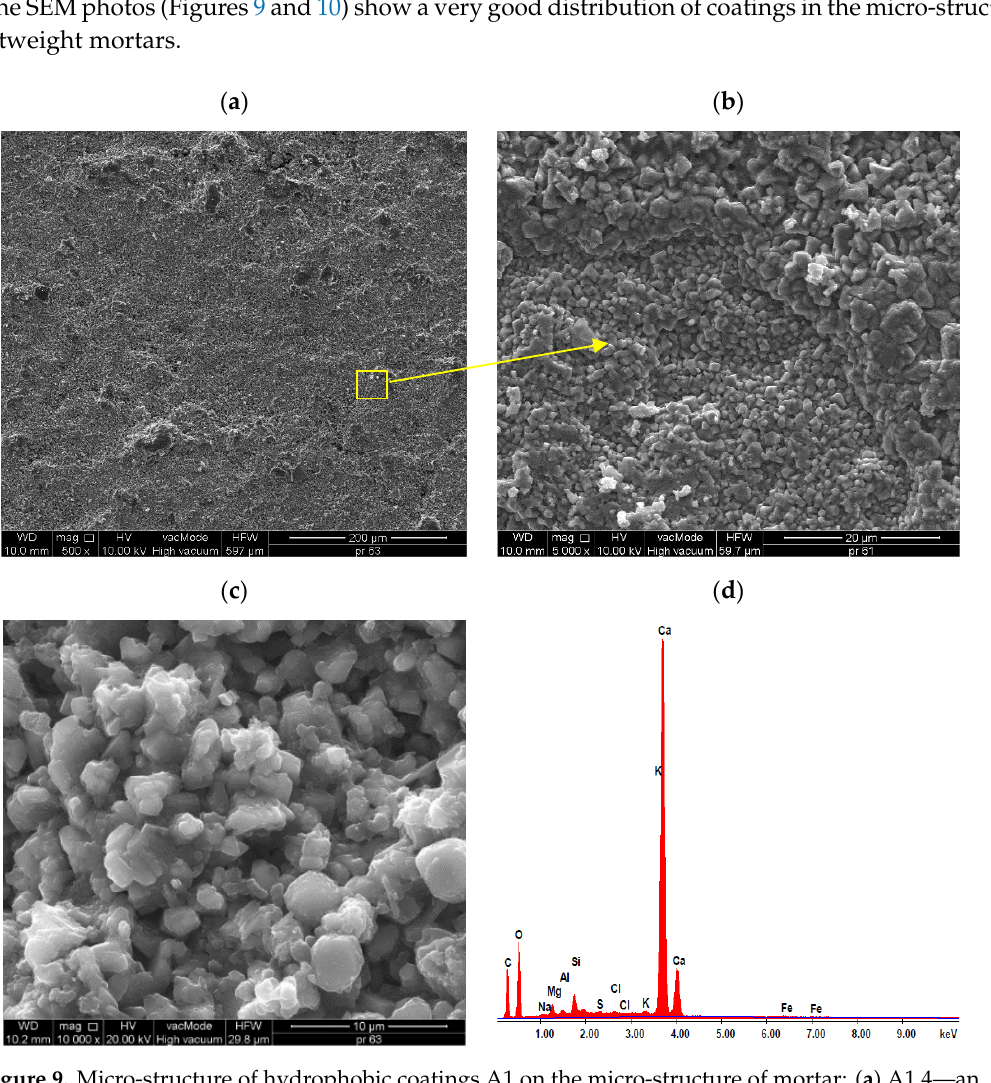
Figure 9. Micro-structure of hydrophobic coatings A1 on the micro-structure of mortar: ( a ) A1.4—an almost invisible thin water-repellent film that has thoroughly covered the surface of the sample ( × 500), ( b ) A1.4—polysiloxane gel molecules ( × 5000), ( c ) A1.4—micro-area well-developed C-S-H phase crystals ( × 10 4 ), ( d ) results of elemental analysis in EDS micro-area from the surface of hydrophobized samples.